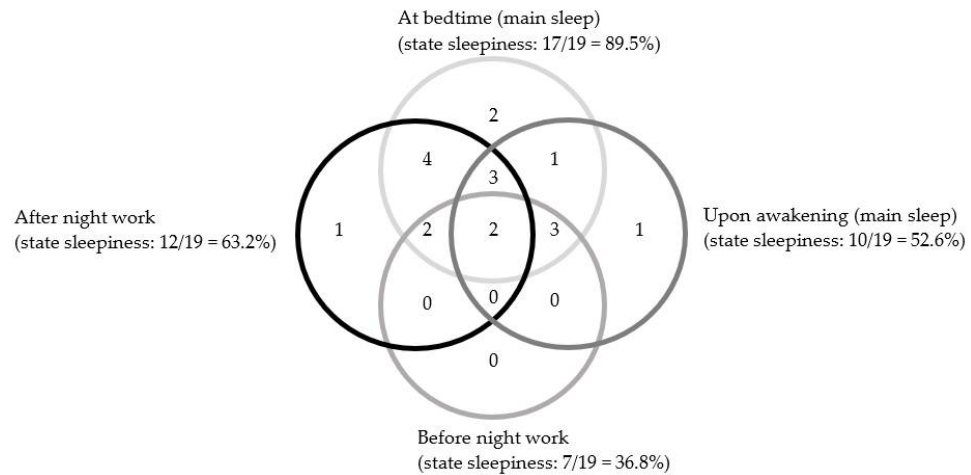
Figure 2. Distribution of night workers with SWD that includes sleepiness symptoms ( n = 19) across four times. Note. The size of circles has no meaning.